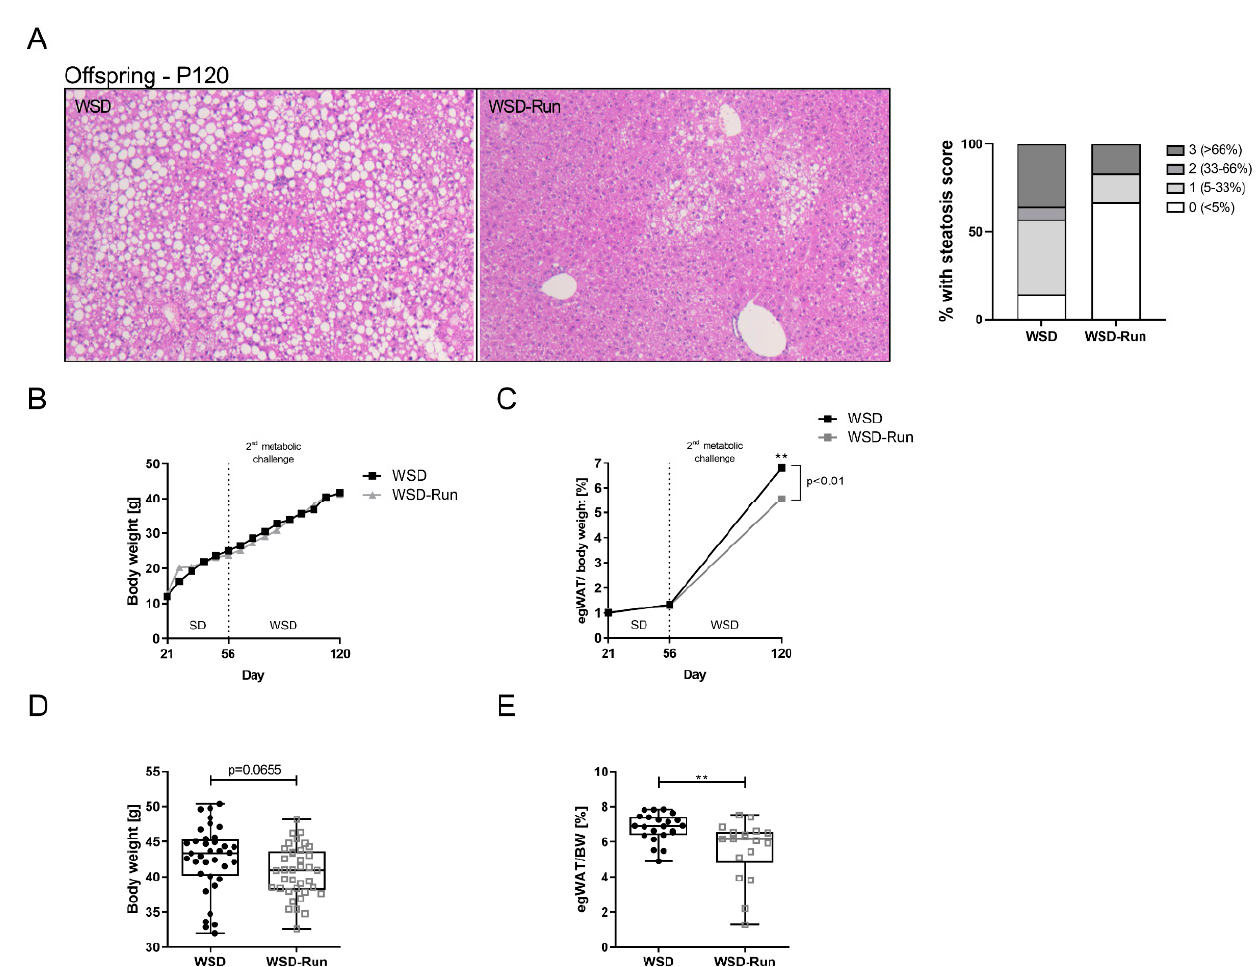
Figure 7. Offspring of exercised obese dams were protected from WSD induced hepatic steatosis and increase in adipose tissue mass in later life (P120). ( A ) Histological analysis of amount of hepatic steatosis after offspring were re-exposed to WSD over a 9-week period later in life. H&E staining, magnification: 20×. Percentage of steatosis, scored as 0 (<5%); 1 (5–33%); 2 (34–66%) and 3 (>66%) percentage of hepatocytes containing lipid droplets (WSD group (n = 14), WSD-Run group (n = 12)). ( B ) Total body weight gain of offspring while re-challenged with WSD from P56 until P120. ( C ) Increase in epigonadal fat mass of the offspring after re-exposure to WSD. ( D ) Total body weight after 9 weeks of WSD at P120 (WSD group (n = 24), WSD-Run group (n = 22)). ( E ) Epigonadal fat pad weight at P21 (WSD group (n = 22), WSD-Run group (n = 18)). Data are presented as mean ± standard deviation; ** p < 0.01.